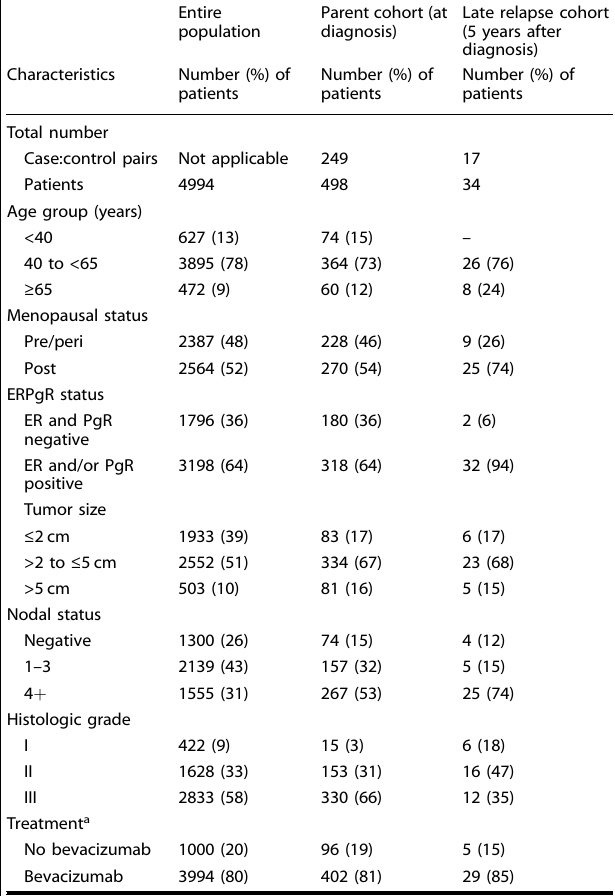
Table 1. Baseline demographics and disease characteristics for factors used to create propensity score for matching at diagnosis and 5 years after diagnosis without recurrence within 5